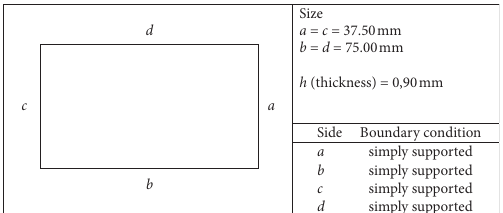
Table 11: Geometrical properties and boundary conditions (Case